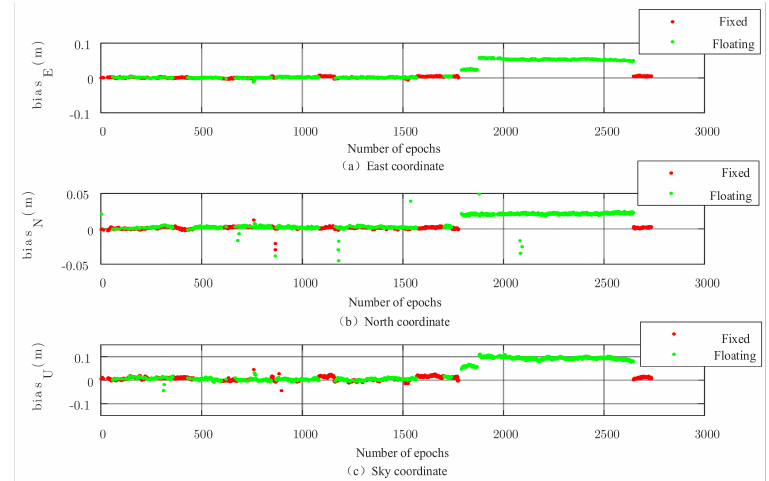
Figure 7. 3D baseline solution of the FAR algorithm.